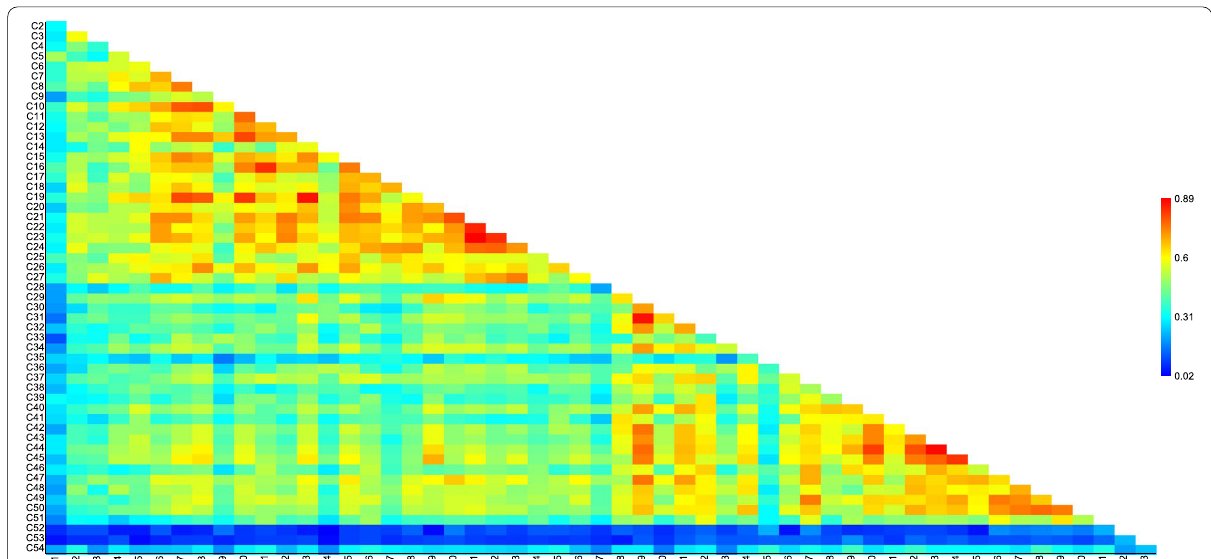
Fig. 4 Jaccard’s similarity coefficient analysis amongst 54 different Capsicum accession. Red and blue colors correspond to high and low degree of similarity between the